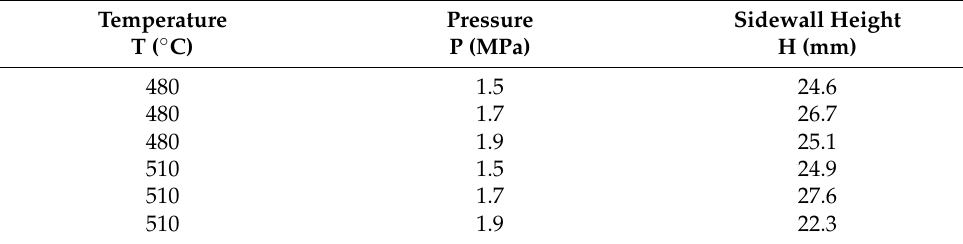
Table 4. Box-shaped part sidewall height